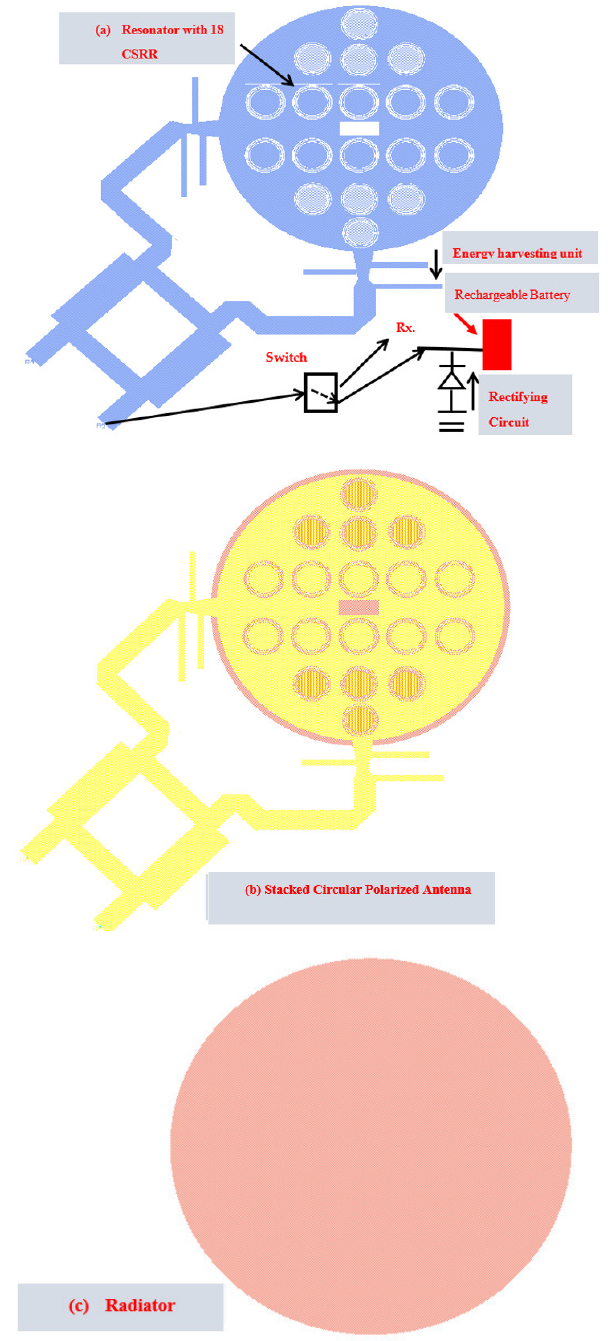
Figure 25. Metamaterial Circular Polarized Patch with a harvesting unit, for IoT and medical applications. ( a ) Resonator with CSRRs ( b ) Stacked circular polarized patch ( c ) Radiating patch.